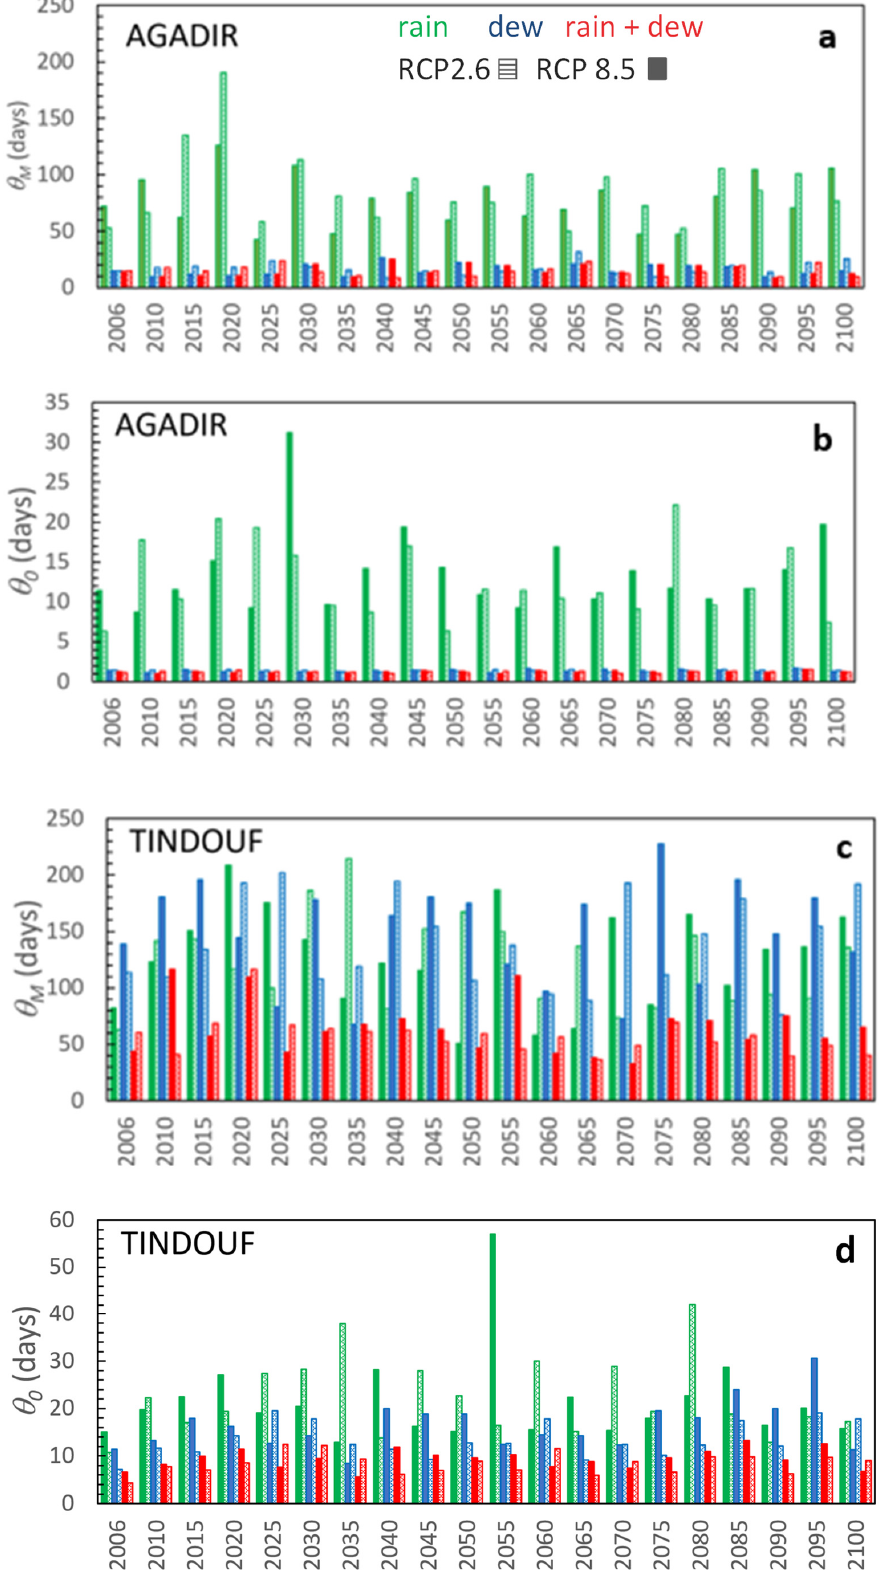
Figure 11. Evolution of lapse times θ M and θ 0 (yearly values, 5 years timestep) for the coastal city Agadir ( a , b ) and the inland city Tindouf ( c , d ) sites from 2006 to 2100), according to both RCP scenarios (RCP 2.6: textured bars; RCP 8.5: full bars). The rain is green, dew is blue and rain + dew is